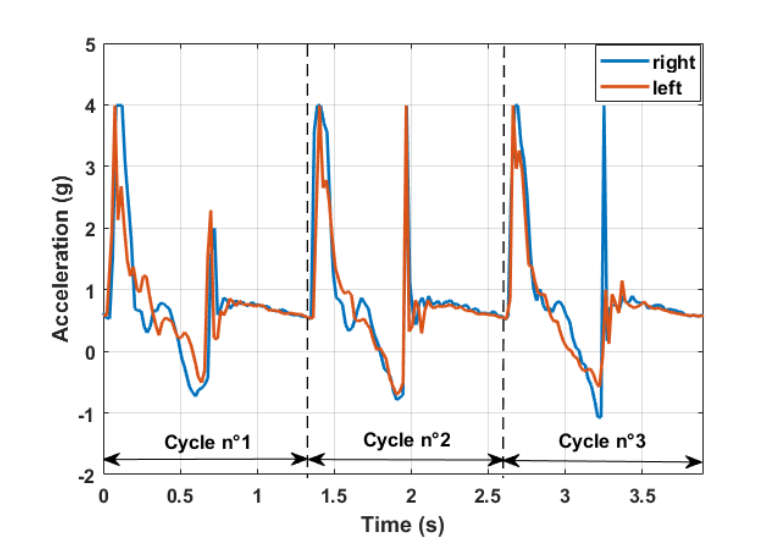
Figure 7. Parallel pushing technique.